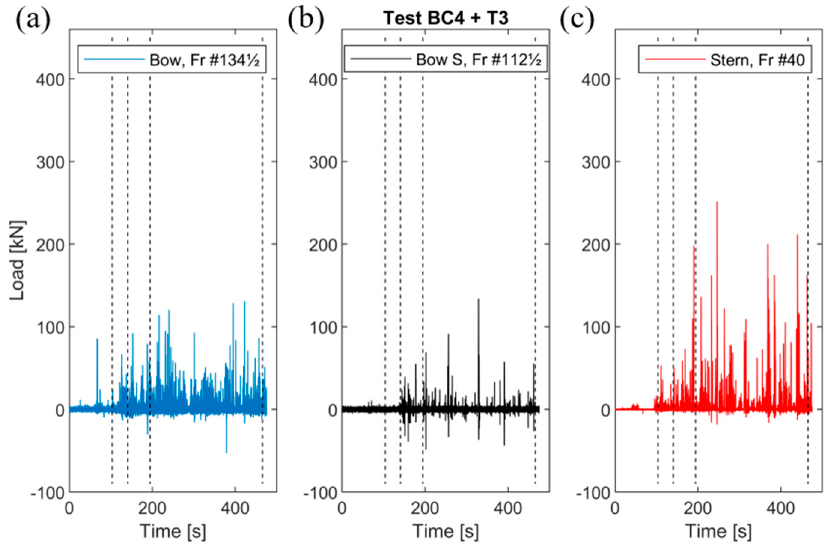
Figure A9. Measured ice-induced loads at ( a ) bow, ( b ) bow shoulder, and ( c ) stern shoulder during tests BC4 and T3.